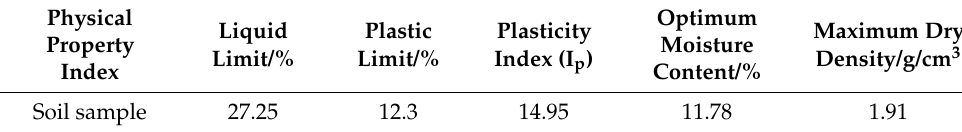
Table 1. Basic physical properties of undisturbed soil samples.